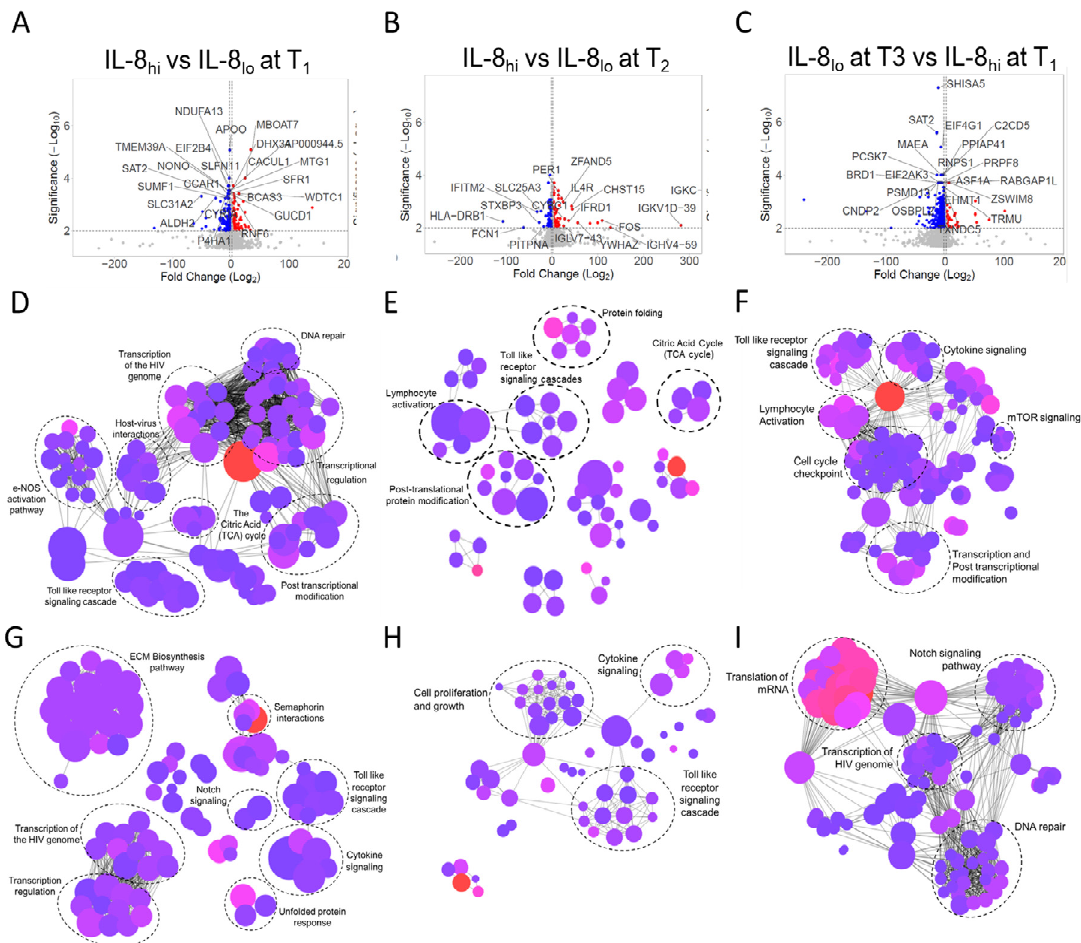
Figure 6. Analyses of immunocellular transcriptome from peripheral blood mononuclear cells from severe COVID-19 patients. ( A – C ) Differentially expressed genes (more than 2-fold change) shown in a volcano plot, analyzed from RNA sequencing data generated from peripheral blood mononuclear cells, compared between patients falling into the IL8 hi group at time-point T1 (N = 9), designated T1 hi, and patients falling into the IL8 lo group at time-point T1 (N = 8), designated T1 lo ( A ), between patients falling into the IL8 hi group at time-point T2 (N = 7), designated T2 hi, and patients falling into the IL8 lo group at time-point T2 (N = 6), designated T2 lo, ( B ) and, finally, between patients who were classified as IL8 hi at time-point T1 (N = 5), designated T1 hi, and ended up falling into the IL8 lo group at time-point T3, designated T3 lo ( C ). ( D – F ) Network depictions of major pathway groups enriched by genes upregulated in T1 hi compared to T1 lo ( D ), upregulated in T2 hi compared to T2 lo ( E ), and upregulated in T3 lo compared to T1 hi ( F ). ( G – I ) Network depictions of major pathway families enriched by genes downregulated in T1 hi compared to T1 lo ( G ), downregulated in T2 hi compared to T2 lo ( H ), and downregulated in T3 lo compared to T1 hi ( I